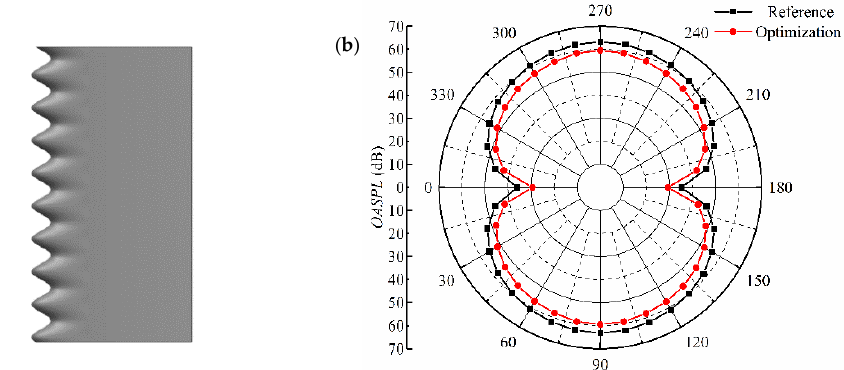
Figure 11. Optimization results verification. ( a ) Optimized blade; ( b ) Comparison of the OASPL .